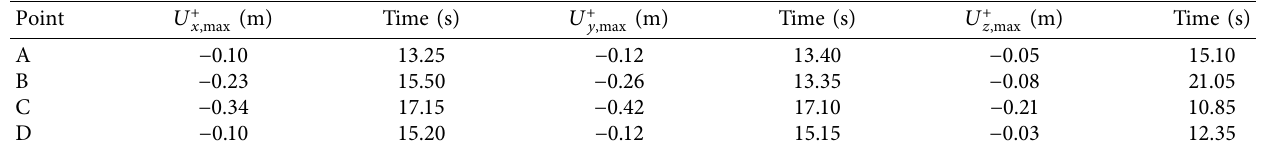
Table 4: Maximum negative displacement.